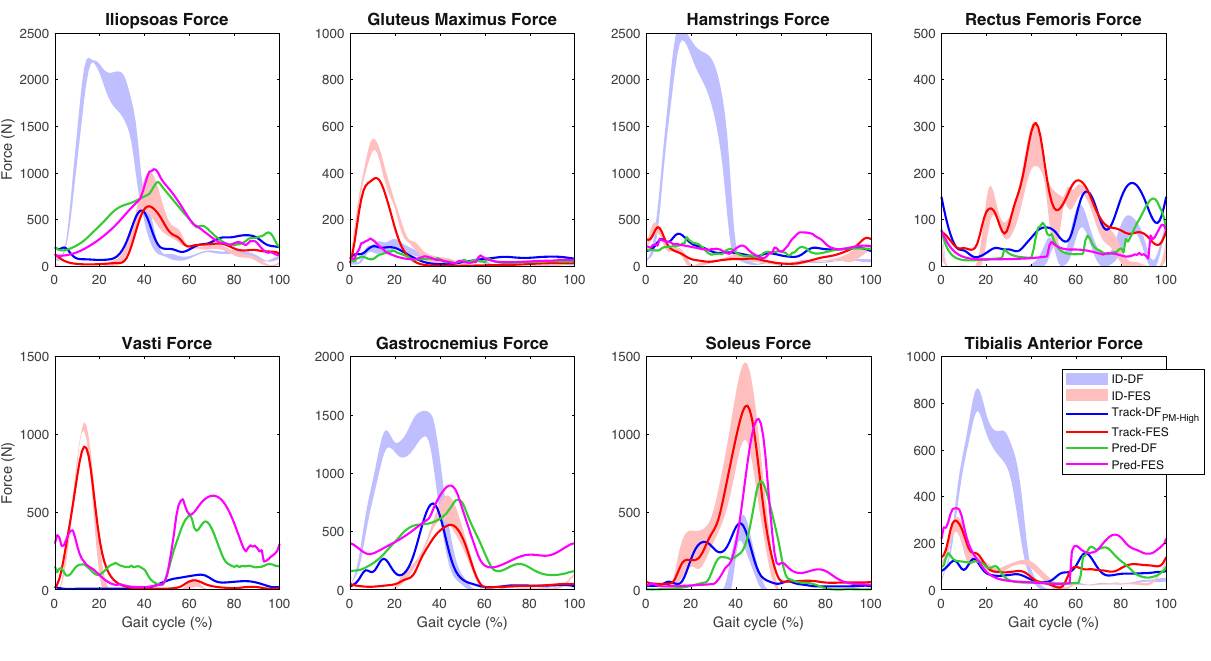
Figure 5. Effect of FES on ID (mean ± standard deviation), tracking, and prediction DF gait (ipsilateral major muscle forces). Contralateral results are presented in Supplementary Fig. S6.